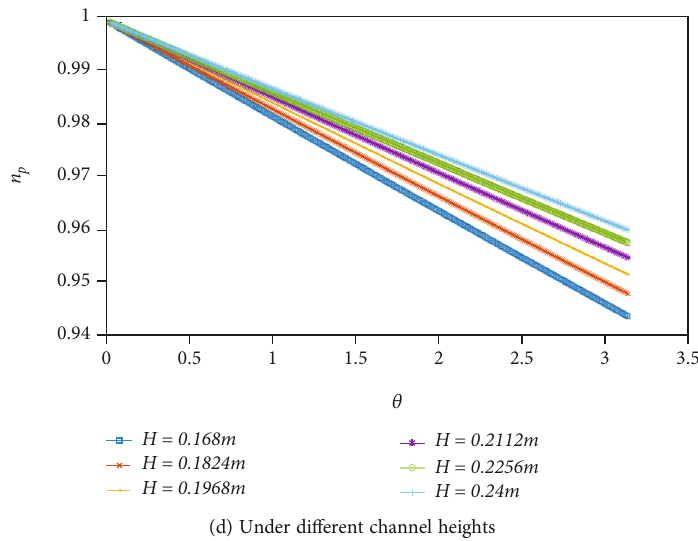
Figure 3: Variation of primary electron density under di ff erent parameters.